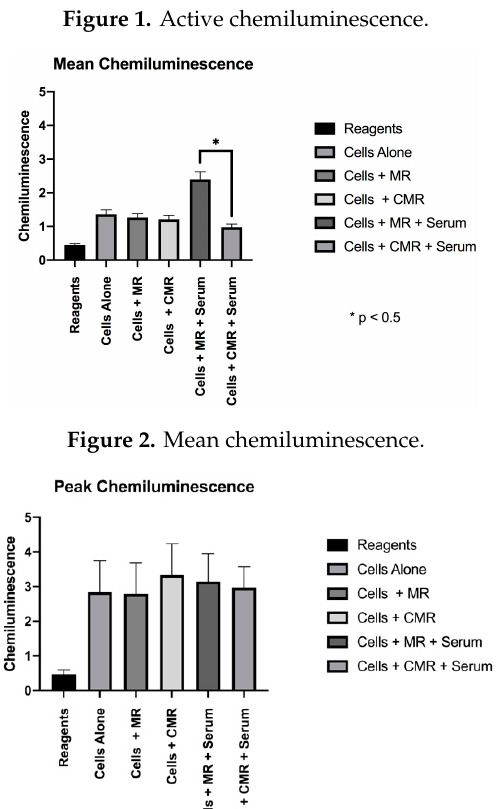
Figure 3. Peak Figure 3. Peak chemiluminescence. Figure 3. Peak chemiluminescence. Figure 3. Peak chemiluminescence.